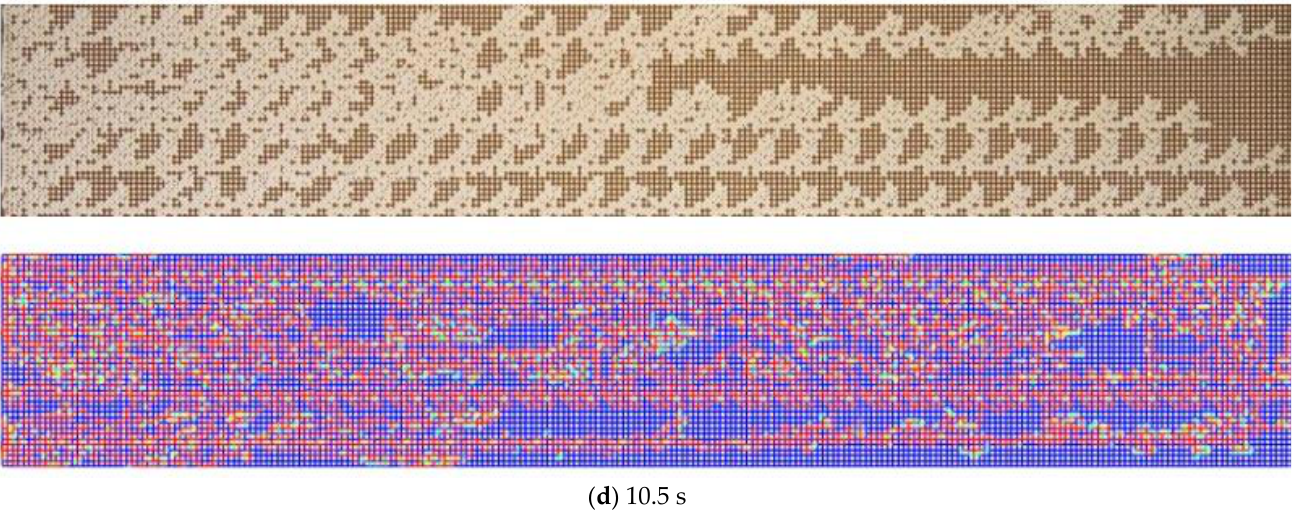
Figure 14. Microchip filling dynamics: comparison of computation (bottom) and experiment (top). Color: blue — oil, red — displaced fluid.